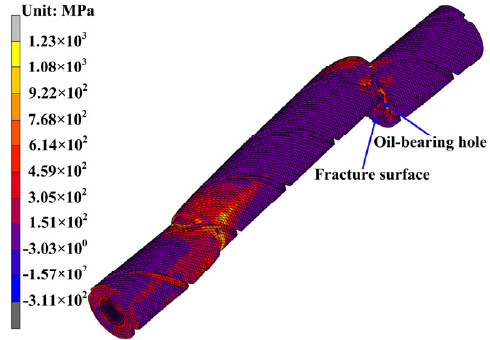
Figure 12. Von Mises stress distribution of the fracture bolt.